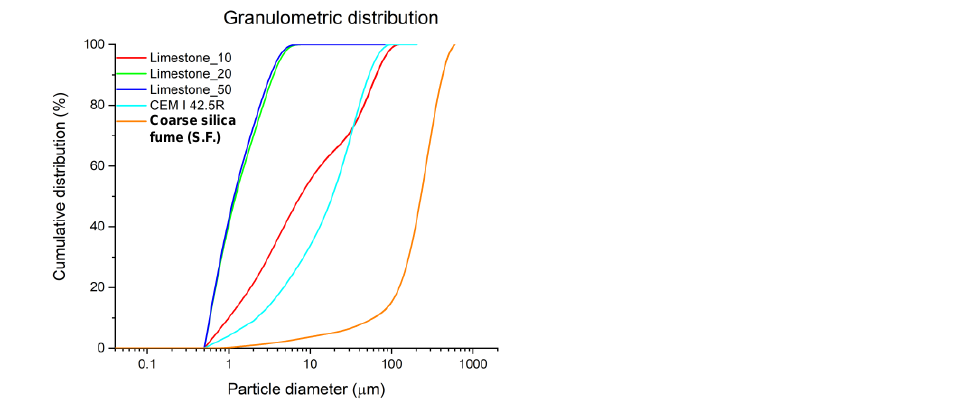
Coarse silica fume (S.F.)